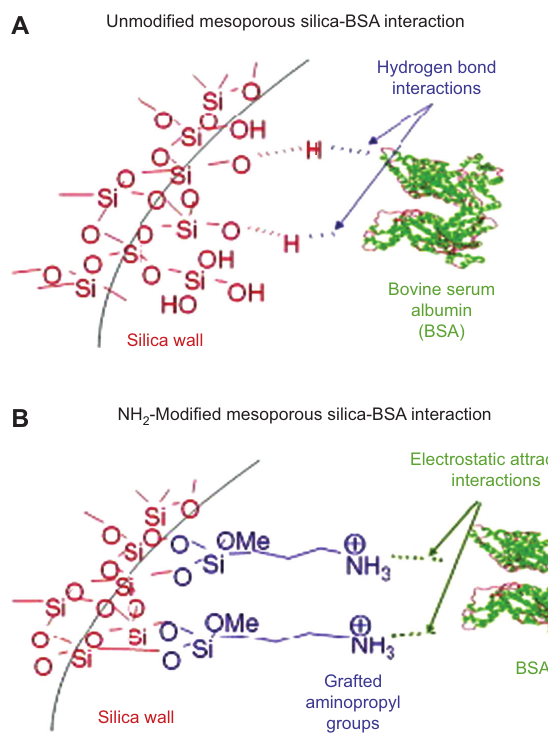
Figure 4 Schematic representation of mesoporous matrix-bovine serum albumin (BSA) host-guest interactions for (A) pure meso- porous silica and (B) aminopropyl-functionalised mesoporous silica [114].